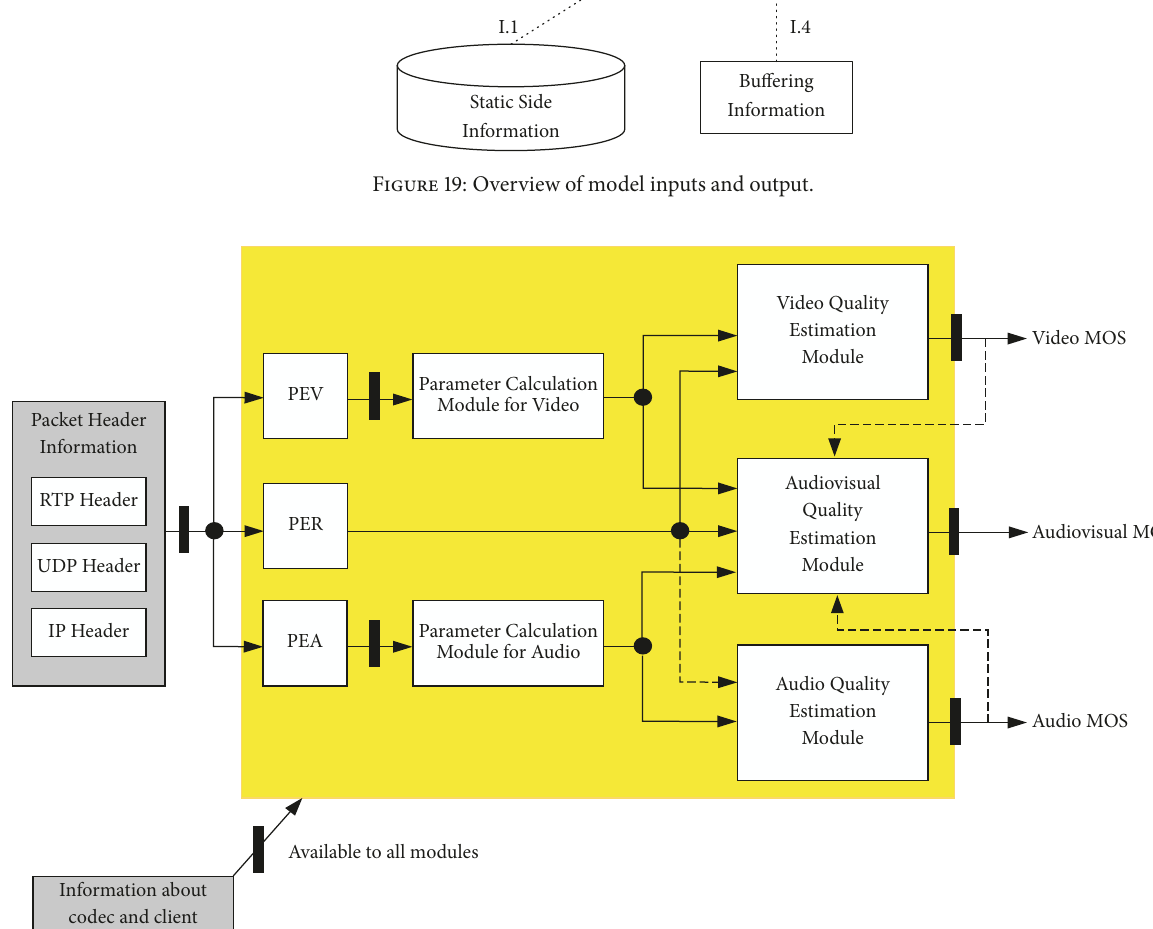
Figure 20: Overall block diagram of ITU-T P.1201.1